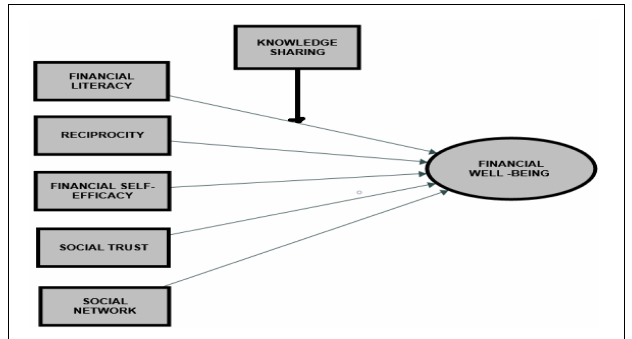
FIGURE 10 | Conceptual